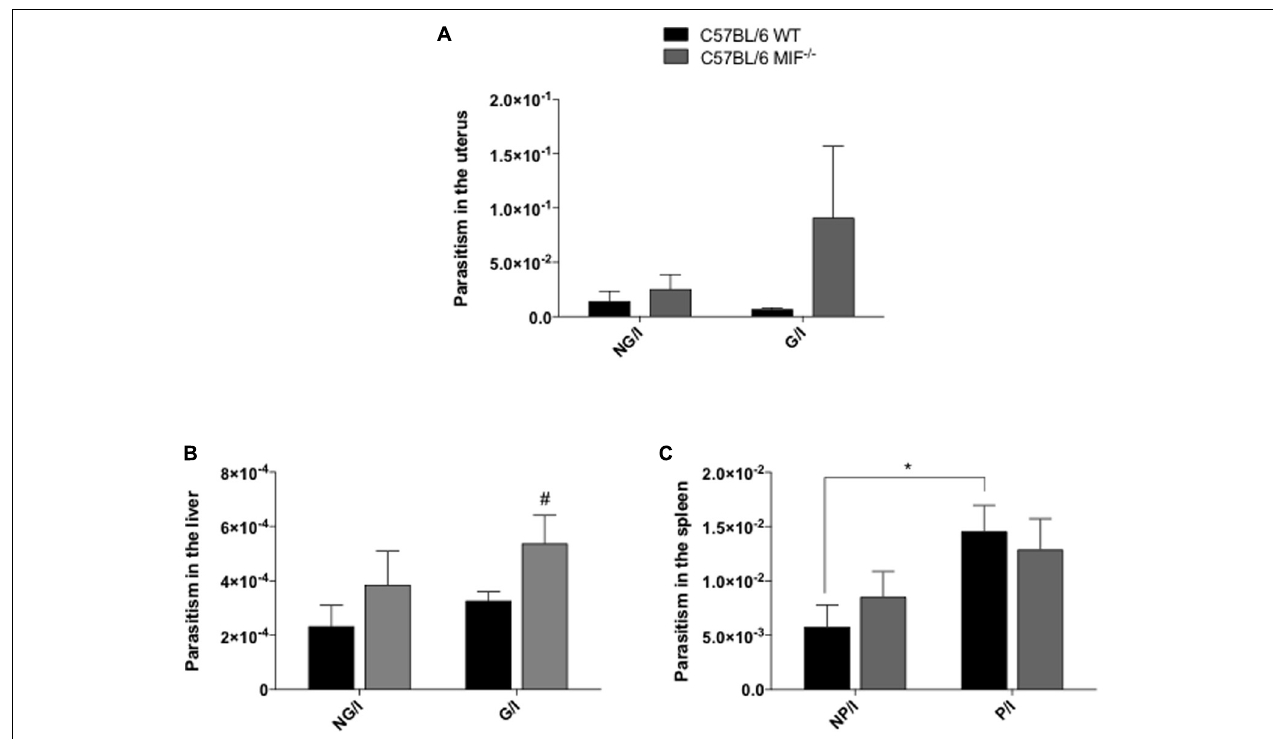
FIGURE 8 | Parasite burden in the (A) uterus, (B) liver, and (C) spleen from non-pregnant and pregnant WT and MIF − / − mice quantified by real-time PCR. Females were orally infected with five cysts of Toxoplasma gondii and euthanized with 8 days of infection/pregnancy. Data are expressed as mean and SEM values obtained from five animals per group. Data were compared by the Kruskal–Wallis test and Dunn’s multiple comparison post-test. # Significant differences between MIF − / − and WT in the same experimental condition ( # P < 0.01). ∗ Comparisons between multiple experimental conditions within the same group (NP/I, non-pregnant/infected; P/I, pregnant/infected) are indicated by bars ( ∗ P <